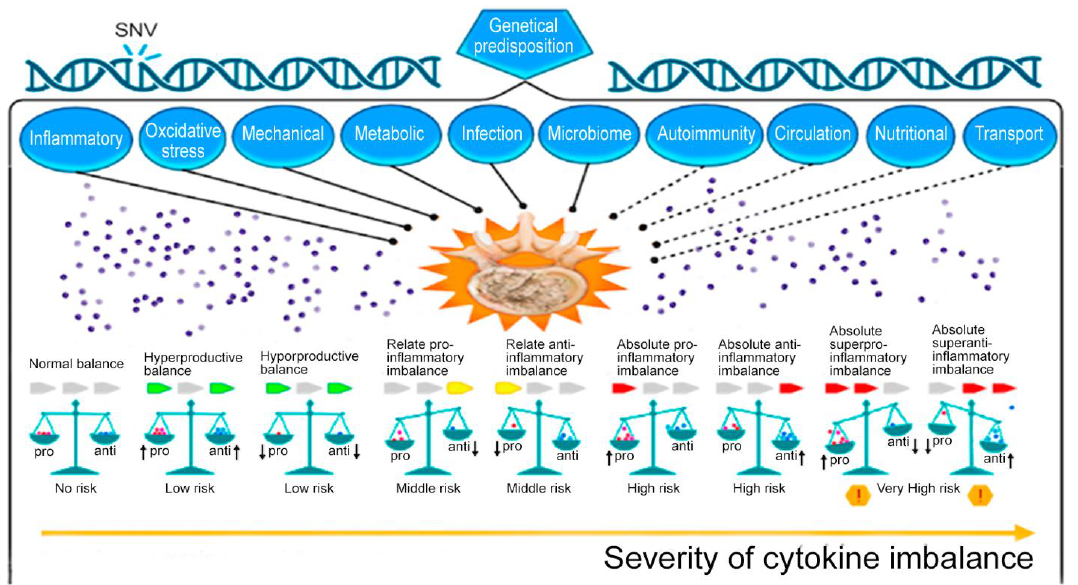
Figure 4. Potential role of normal and abnormal cytokine levels in the cytokine imbalance as a biomarker of intervertebral disk degeneration. Note: SNV — single-nucleotide variant; pro — pro- inflammation cytokines; anti — anti-inflammation cytokines. Note: solid line – well-studied mechanisms of IDD development; dotted line – insufficiently studied mechanisms of IDD development; up arrow – increased cytokine level; down arrow – decreased cytokine level; red exclamation point in a yellow hexagon is a dangerous situation.